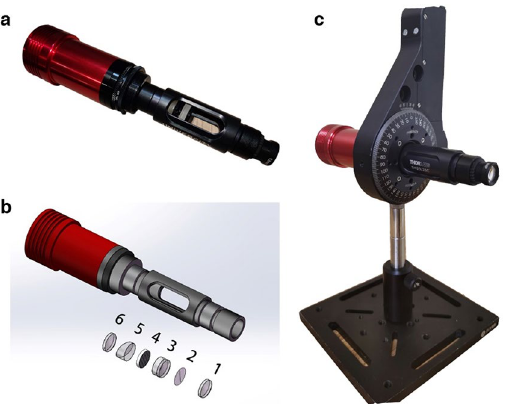
Figure 1. ( a ) The photo of our rotational hyperspectral scanner; ( b ) schematic diagram and optical elements (1. imaging lens; 2. line slit; 3. collimating lens; 4. grating; 5. prism; 6. imaging lens); ( c ) Installed on a rotational